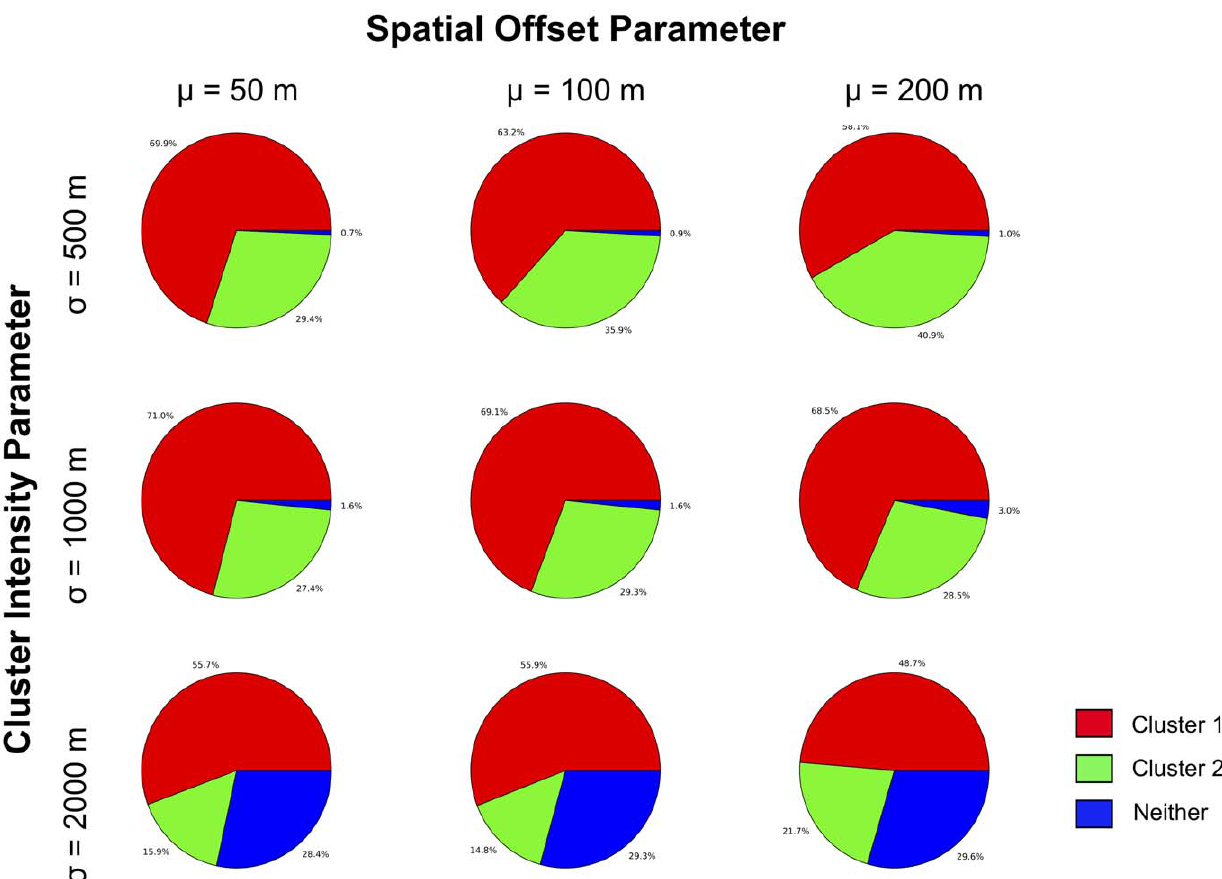
Figure 6. Pie charts showing the proportion of MLCs in the set of perturbed patterns located in the vicinity of Clusters 1 and 2.